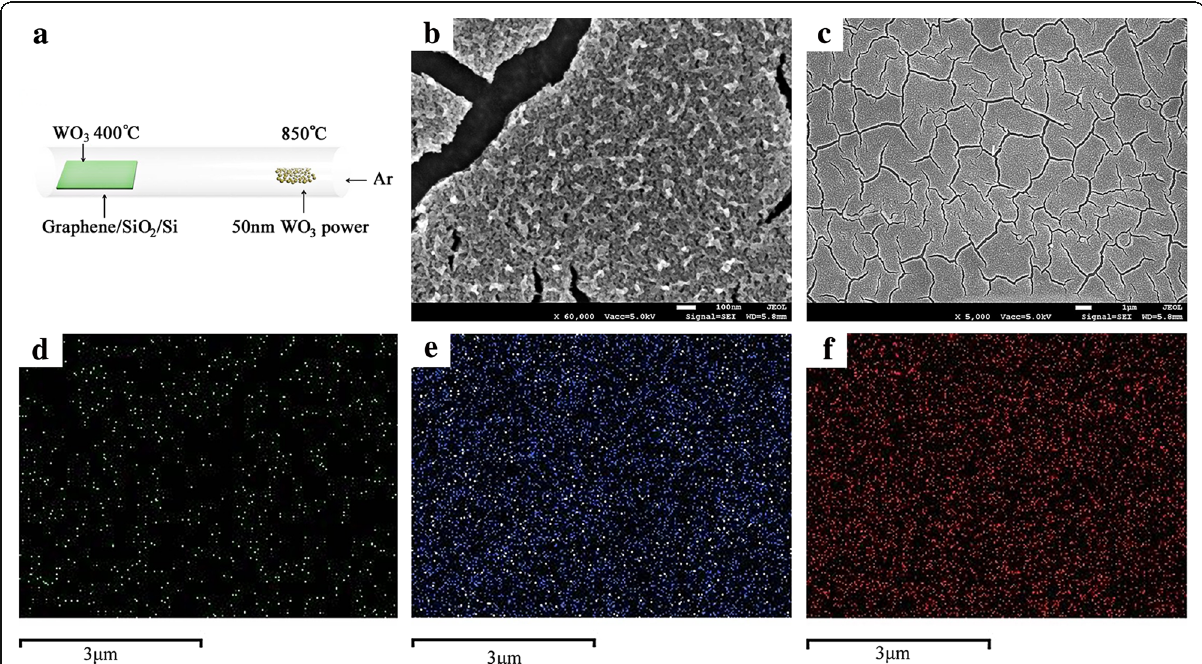
Fig. 1 Schematic of the synthesis and the SEM morphologies of the WO 3 /GR heterostructures. a The 50 nm WO 3 powder is positioned in the same ceramic boat at the inlet side of the tube furnace. b × 60,000 and c × 5000 SEM images. d C e O f WEDS elemental mapping of WO 3